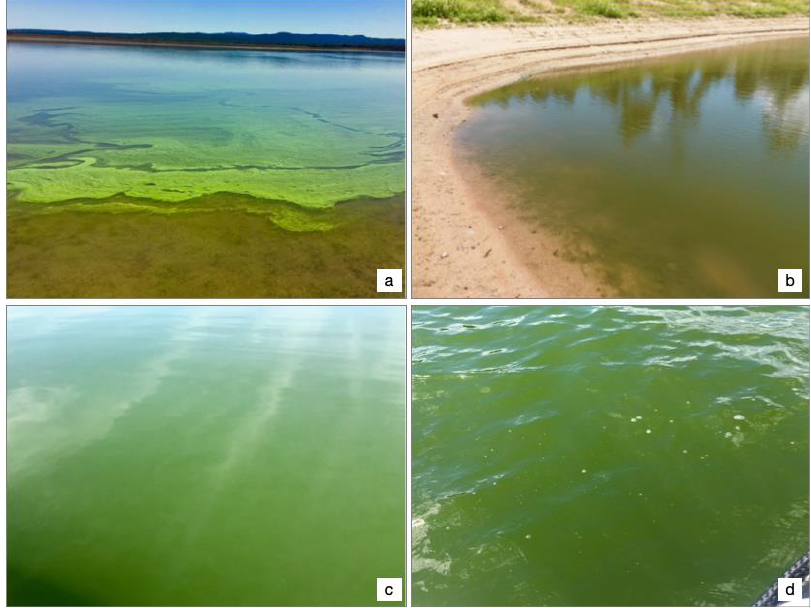
Figure 1. ( a ) Lake Clarendon, with an example of surface scum caused by high concentrations of cyanobacteria; ( b ) Lake Dyer and the impact of cyanobacteria on recreational sites, particularly how it impacts on aesthetic values. Varying levels of cyanobacteria in ( c ) Lake Liddell and ( d ) Lake Baroon. In 2014, the EyeOnWater (EoW) and HydroColor (HC) smartphone applications (Apps) became